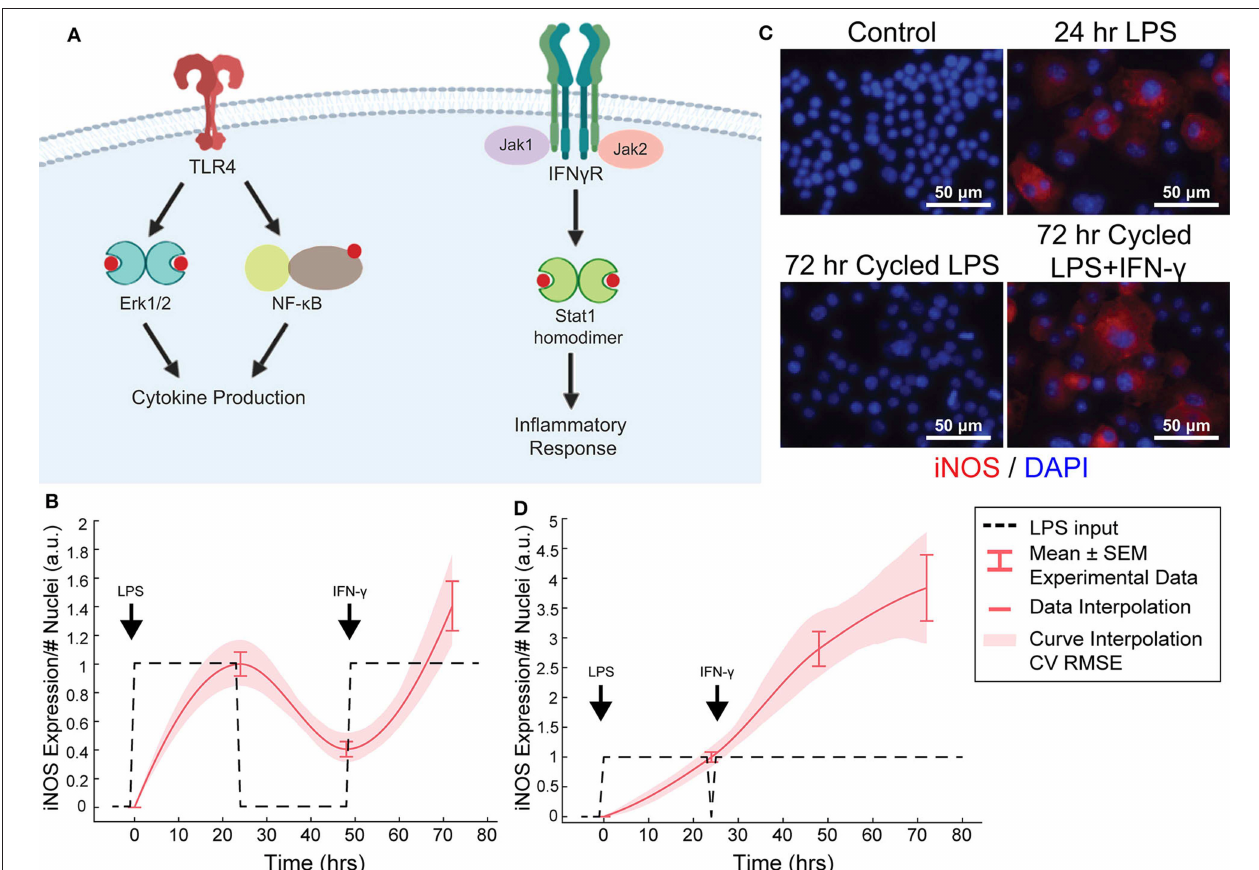
FIGURE 4 | Orthogonal stimuli maintained or magnified iNOS expression. (A) Signaling diagram for LPS and IFN- γ (created with BioRender). (B) 24h of LPS treatment and delayed subsequent IFN- γ (dashed lines) treatment modulates iNOS expression (red curves, mean ± SEM, N = 16; interpolated curve ± RMS CV error), even at 72h time point. (C) Representative ICC images showing cycled LPS and IFN- γ (input defined in B ) induces iNOS expression comparable to 24h of LPS alone while cycling only LPS in that same pattern ( Figure 2F ) does not maintain expression. (D) 24h of LPS treatment and immediately subsequent IFN- γ (dashed lines) treatment modulates iNOS expression (red curves, mean ± SEM, N = 16; interpolated curve ± RMS CV error), even at 72h time point.